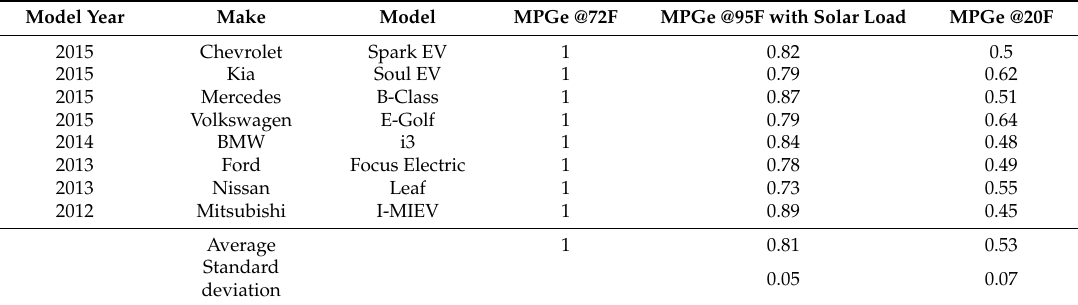
Table A3. Vehicle data for weather conditions vs. fuel economy (Figure 8).